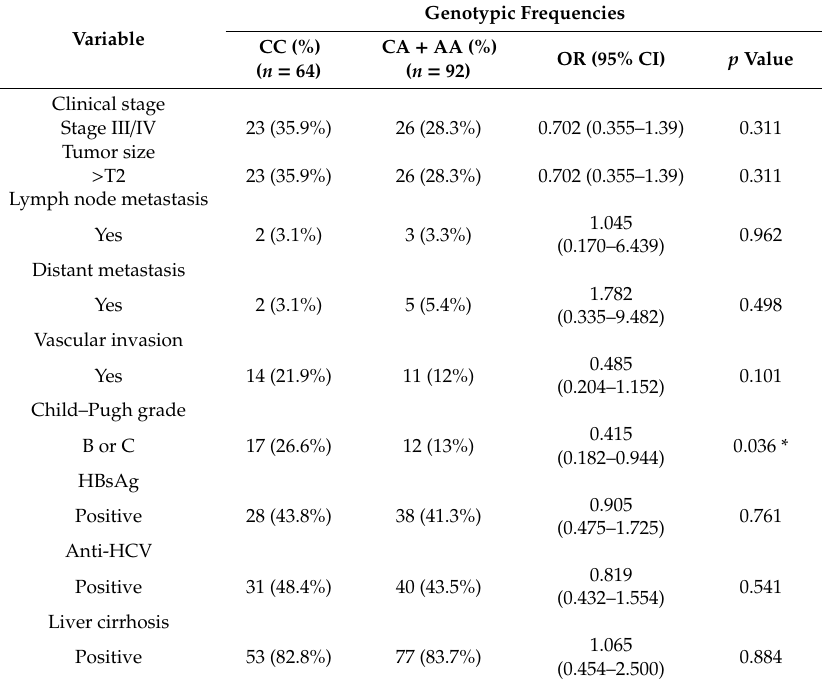
Table 5. Odds ratio (OR) and 95% confidence interval (CI) of the clinical status and MALAT1 rs1194338 genotypic frequencies in 156 hepatocellular carcinoma patients among